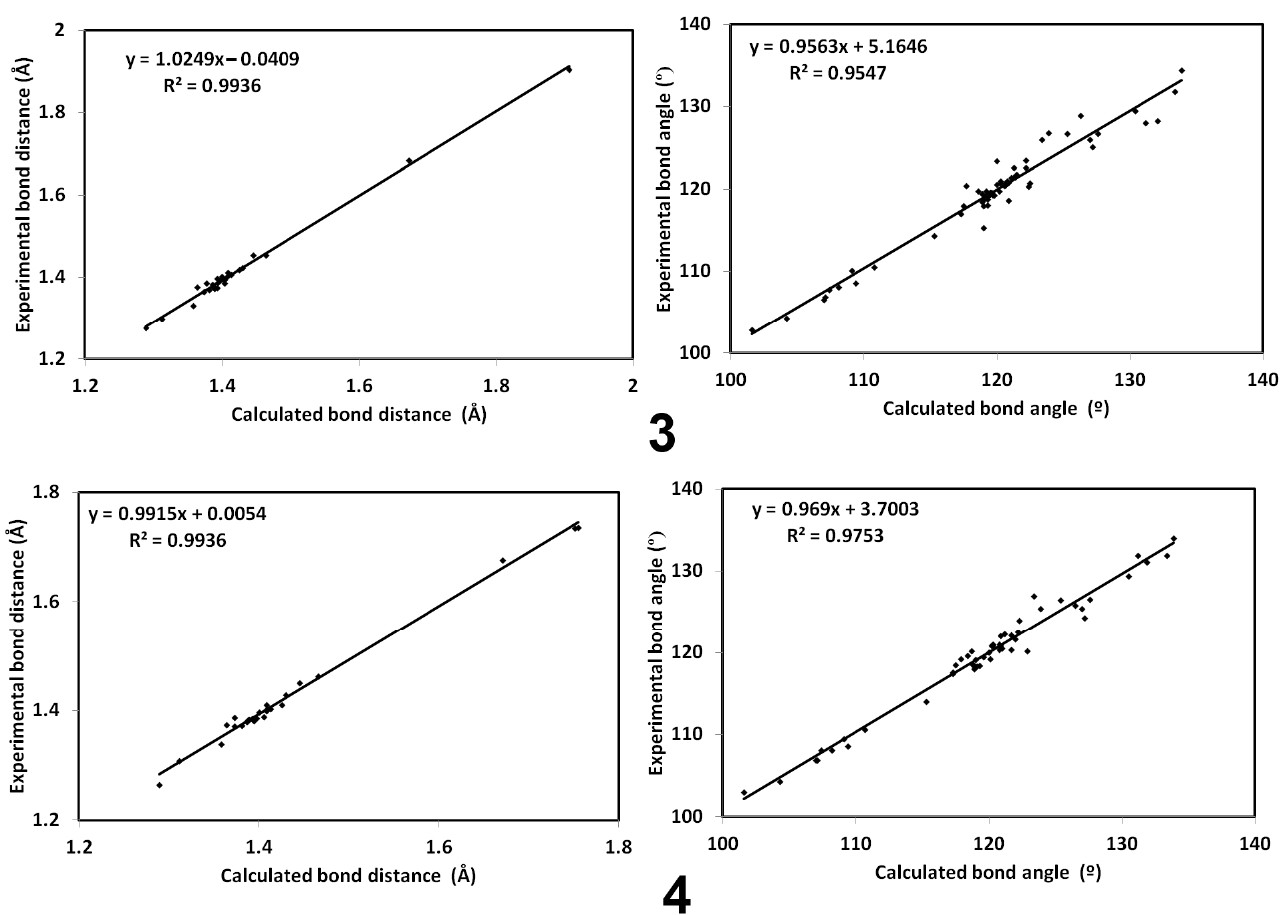
Figure 12. The straight-line correlations between the calculated and experimental geometric parameters.